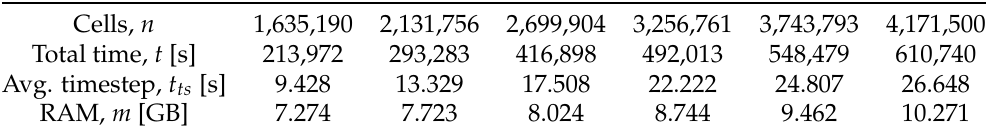
Table A5. AMR generated grids when using the k − (cid:101) model. Refinement frequency is set to 1000 timesteps. Load balancing is disabled. AMR specifics are defined in the manuscript. Presented values are three-run averages. A total of 48 cores are used for all tests. Due to numerical instabilities, the number of outer loops had to be increased ( n loops = 20).